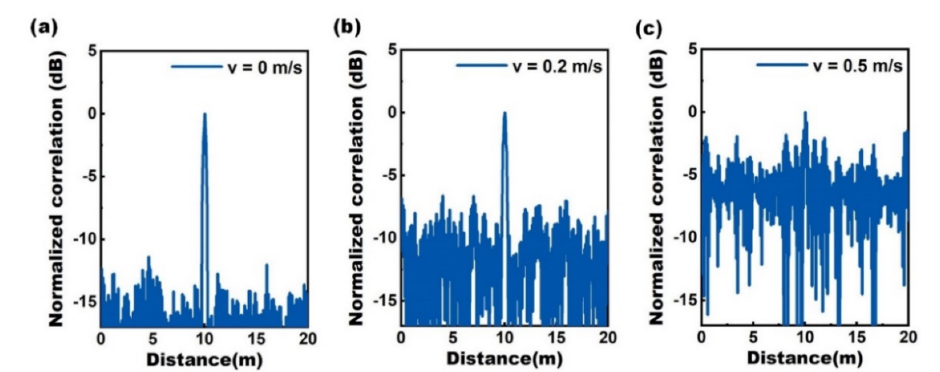
Figure 6. Numeric simulations for the coherent RMCW LiDAR to detect moving targets with different velocities. The velocity of the target is ( a ) 0 m/s, ( b ) 0.2 m/s and ( c ) 0.5